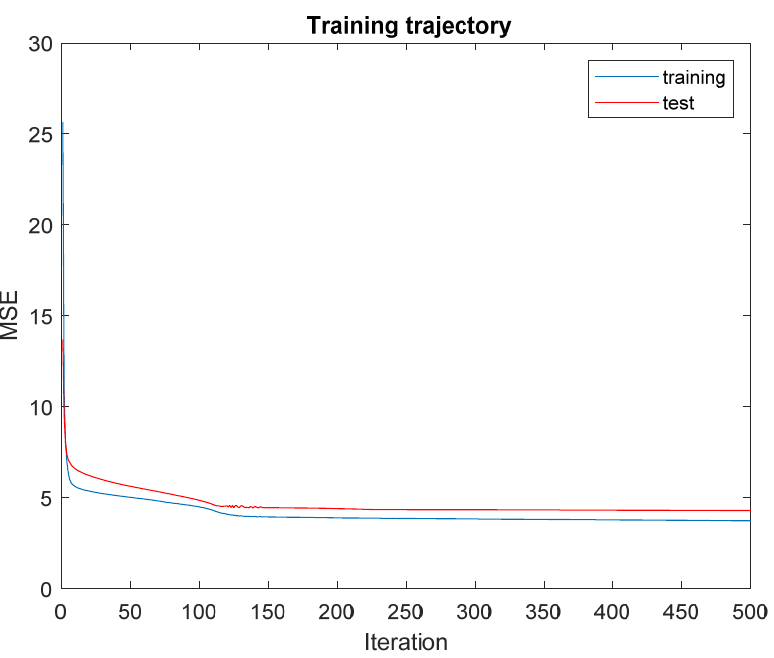
Figure 7. Training trajectory of the k-Means-clustering-hybridized neuro-fuzzy classifier trained through gradient descent.